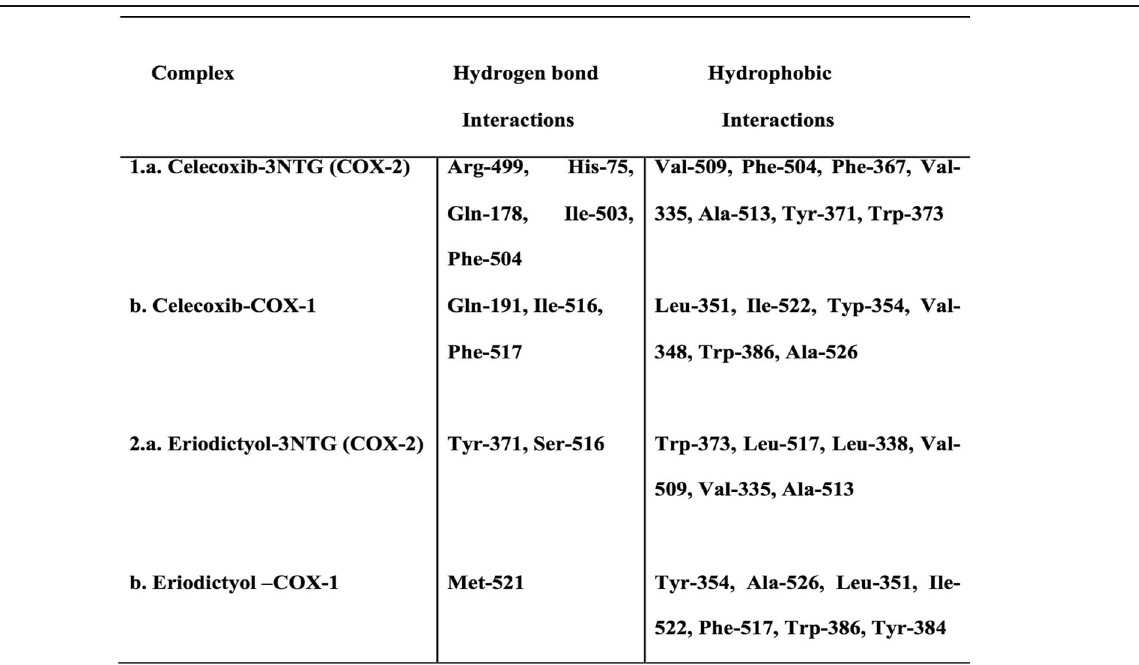
Table 2 Amino acids interactions of Celecoxib and the lead, Eriodictyol with COX-2 and